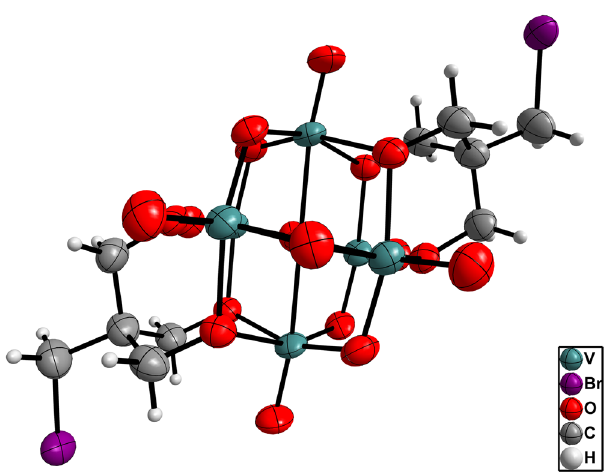
Figure 5. ORTEP drawing of the anionic cluster of compound 3 . Thermal ellipsoids are drawn at the 50% probability level. Colour scheme: V = teal; O = red; Br = purple; C = grey; H = light